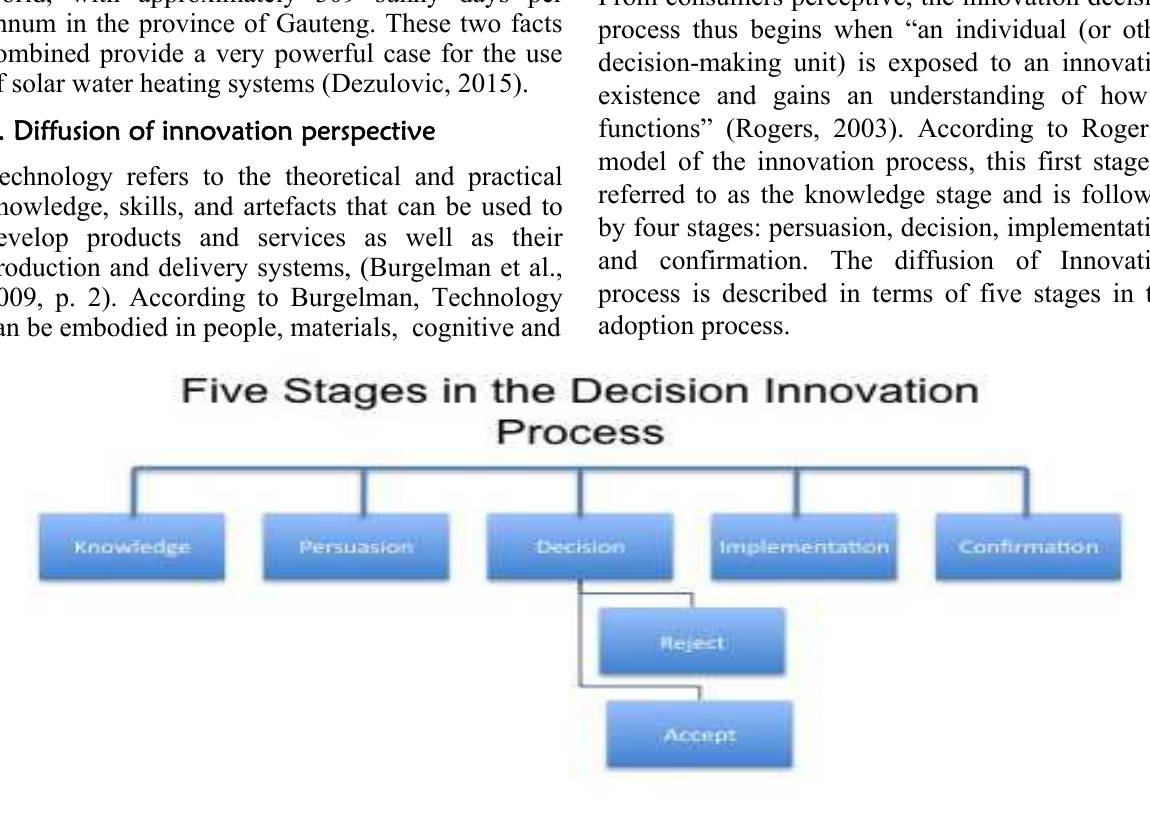
Fig. 6. Five stages in the decision innovation